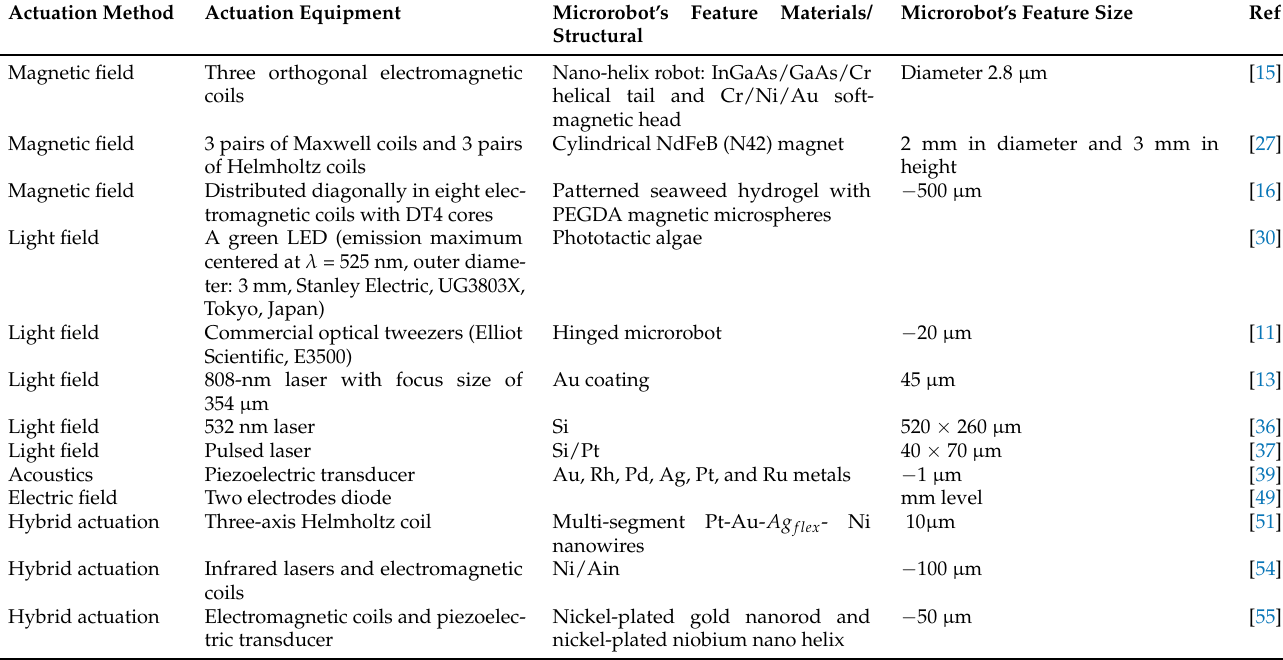
Table 1. Summary of mainstream actuation